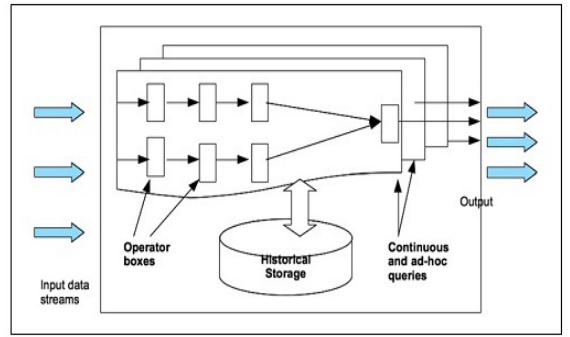
Figure 2: Aurora architecture